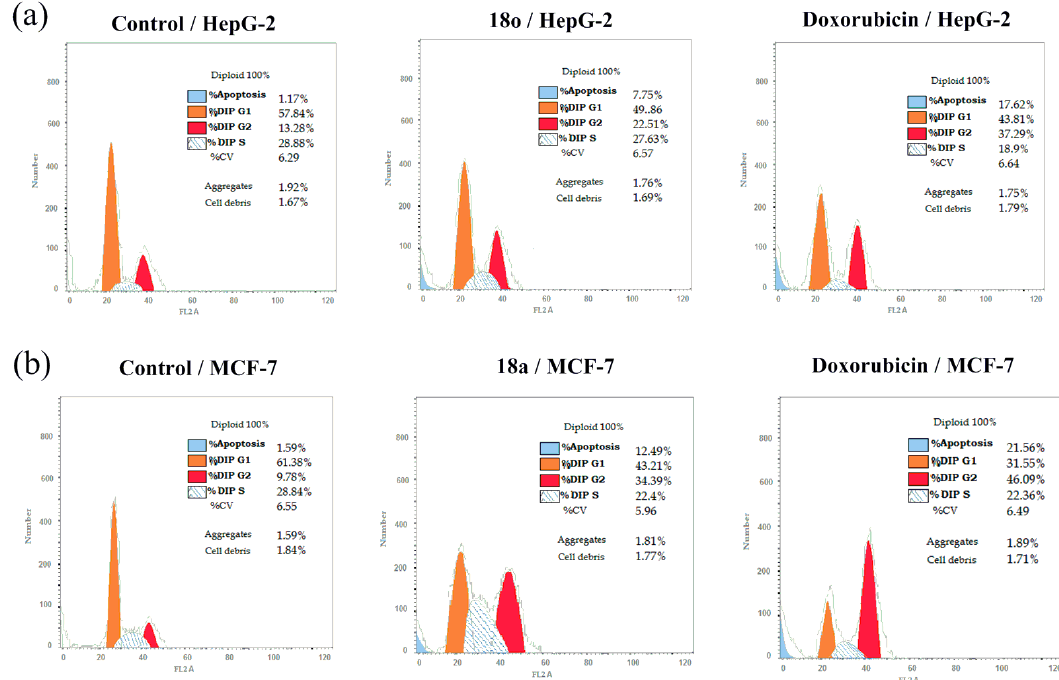
Figure 5. ( a ) Effect of compound 18o on DNA-ploidy flow cytometric analysis of HepG-2 cancer cells, the cells were treated with DMSO as control and with doxorubicin as a positive control, for 24 h. ( b ) Effect of compound 18a on DNA-ploidy flow cytometric analysis of MCF-7 cancer cells, the cells were treated with DMSO as control and with doxorubicin as a positive control, for 24